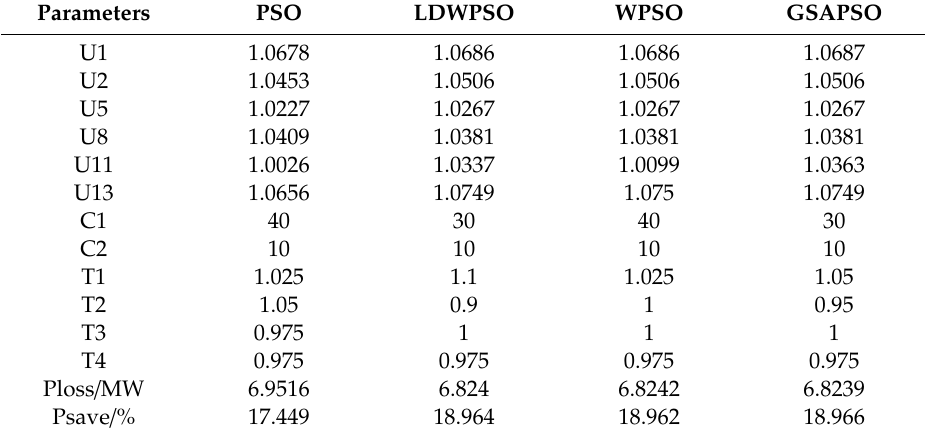
Table 6. The optimized control variables with four optimization algorithms.